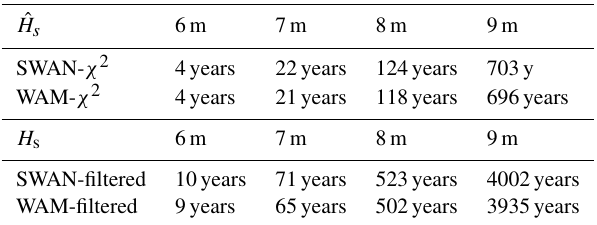
Table 4. The estimated return period at the Bothnian Sea wave buoy for the significant wave height with sampling variability ( ˆ H s ) and without sampling variability ( H s ). Estimates based on averaging distributions with ξ = 0 (italicised in Table 3). For a description of the data sets (e.g. WAM- χ 2 ), see Table